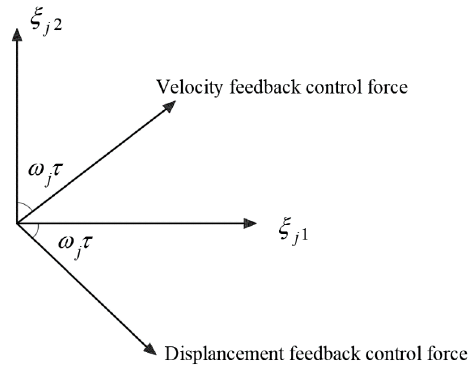
Figure 4. Phase difference between control force and response.